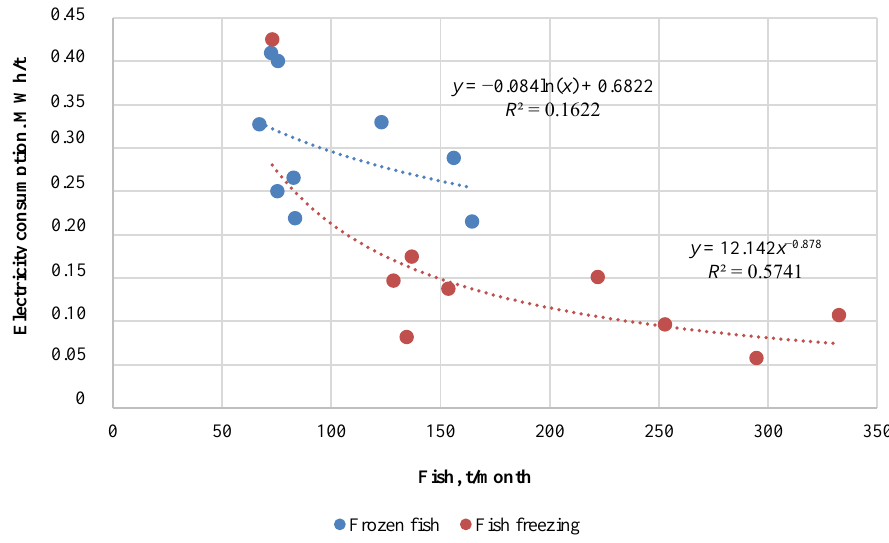
Fig. 5. Fish freezing and frozen fish